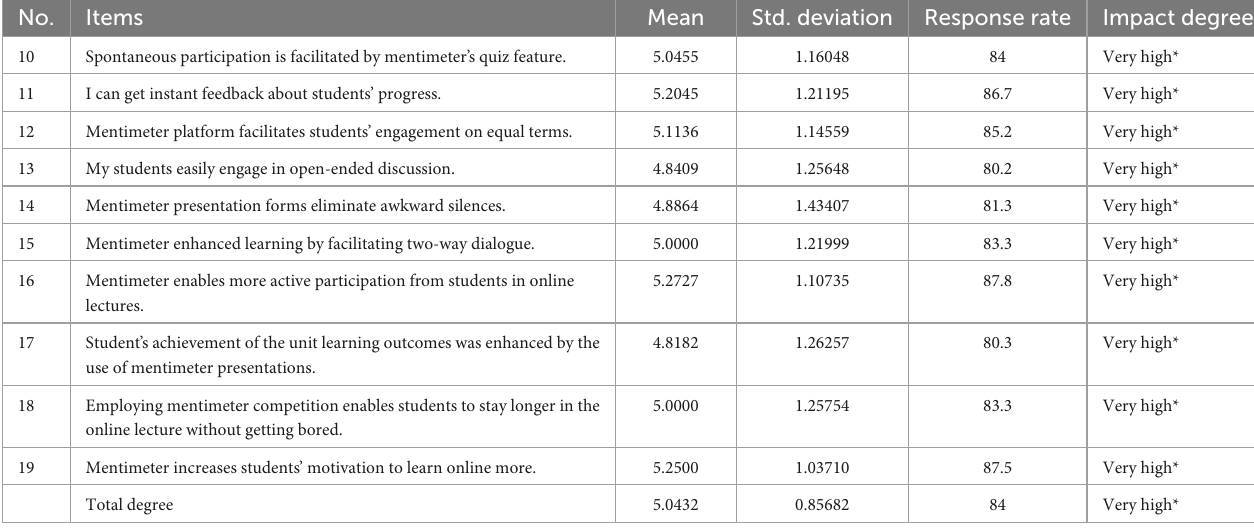
Mentimeter presentation forms eliminate awkward